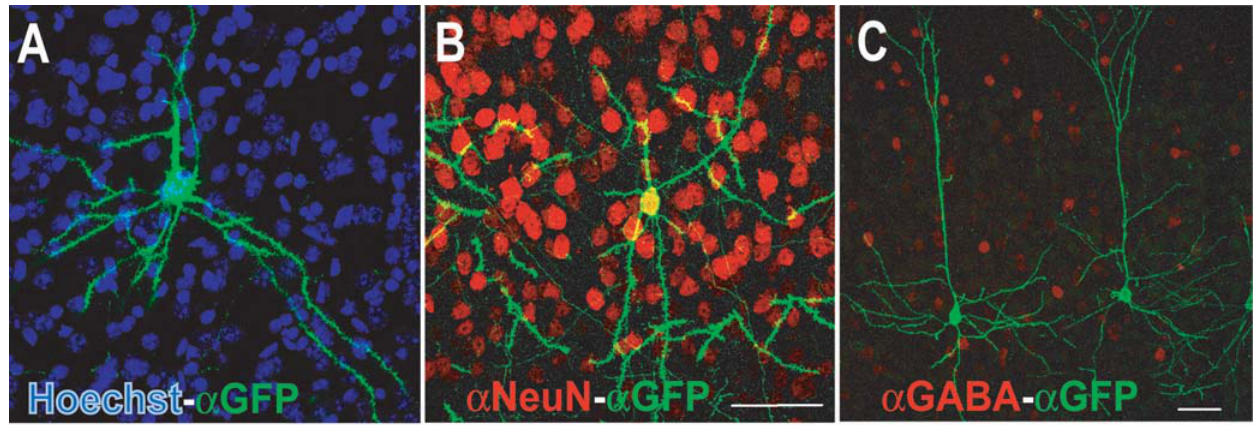
Figure 2. Mosaic expression of EGFP-F in the cortex is confined to excitatory neurons. (A) A confocal image of a 50 m m section of the visual cortex of two month old TLG 498 + Cre 3487 + transgenic mice for antibodies against GFP (green) and counterstained with Hoechst 33342 (blue nuclei) shows the low recombination efficiency. (B) Double immunofluorescence for antibodies against GFP (green) and the neuronal marker NeuN (red) show colocalization of NeuN in EGFP-F expressing cells. (C) In the cortex there is no colocalization of EGFP-F with GABA, a marker for inhibitory neurons (red). Scale bar: 50 m m. doi:10.1371/journal.pone.0003059.g002 TLG 498 + Cre 3487 + transgenic mice for further breeding, as mice carrying a floxed gene and Cre 3487 + is essential for some germline recombination sometimes occurred resulting in broad reason, we recommend genetic testing of the offspring to exclude EGFP-F expression in the next generation. In case the breeding of germline recombination before use or further breeding.